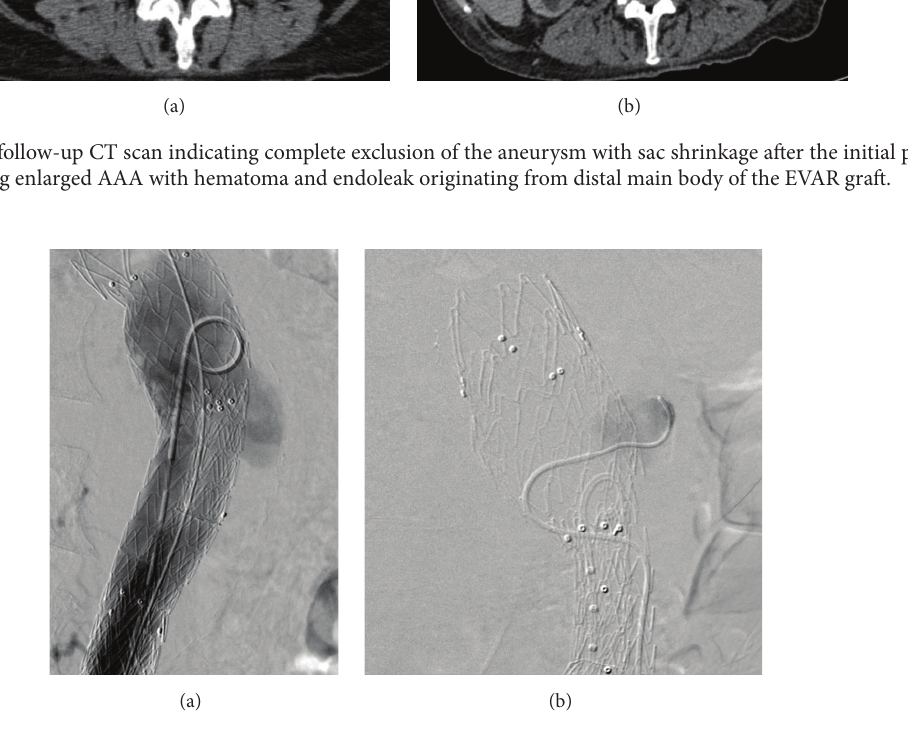
Figure 2: (a) Angiogram showed endoleak at the level of the bifurcation endograft. (b) Direct catheterization of the aneurysm sac through the tear of the